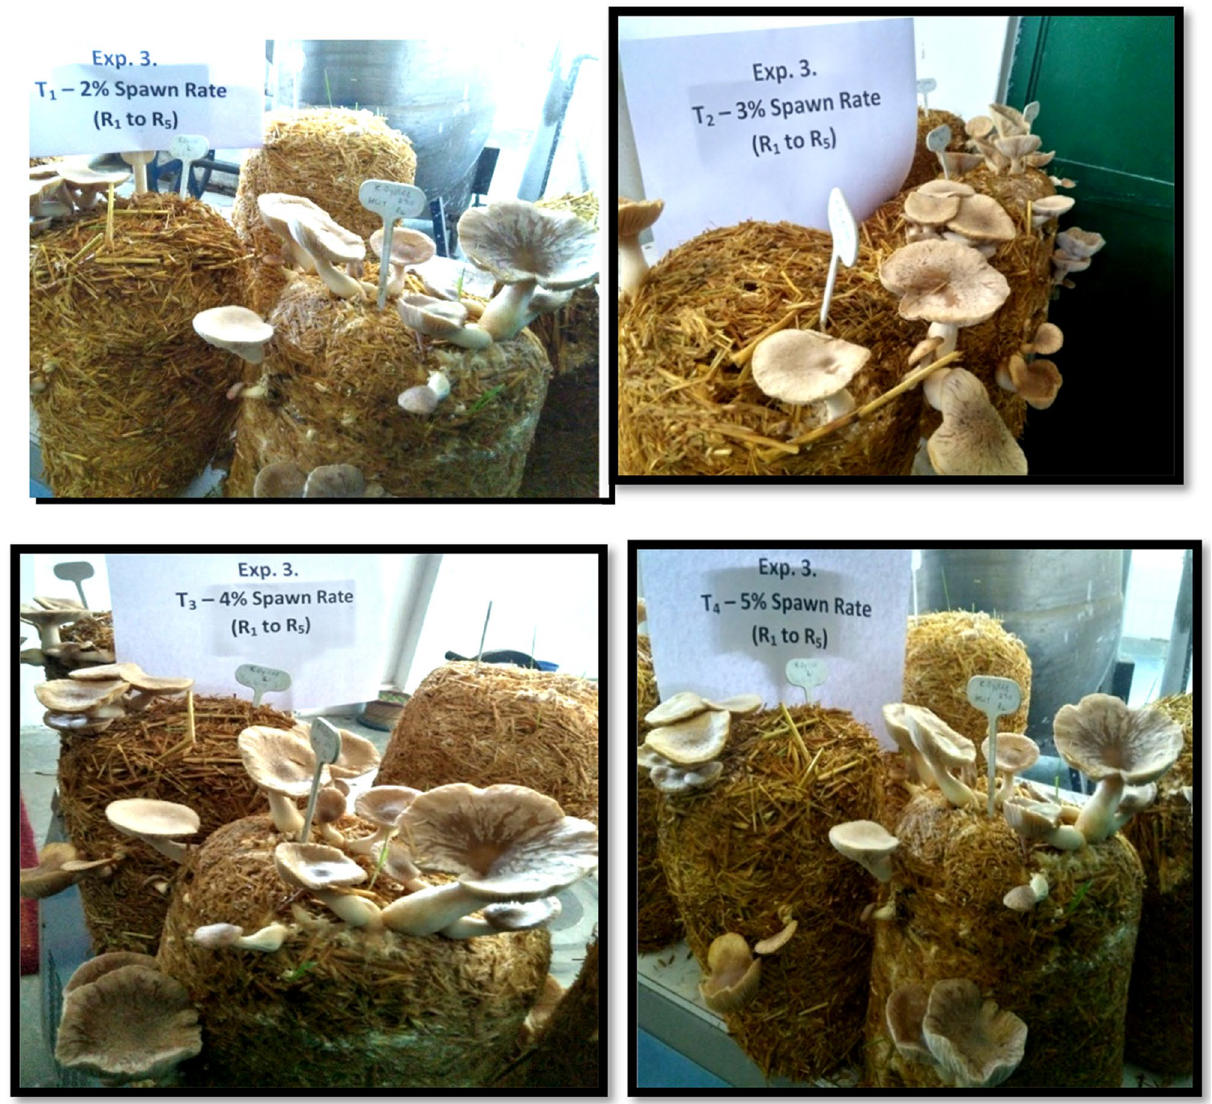
Figure 6. Photographs of different spawn rates for P. eryngii production.